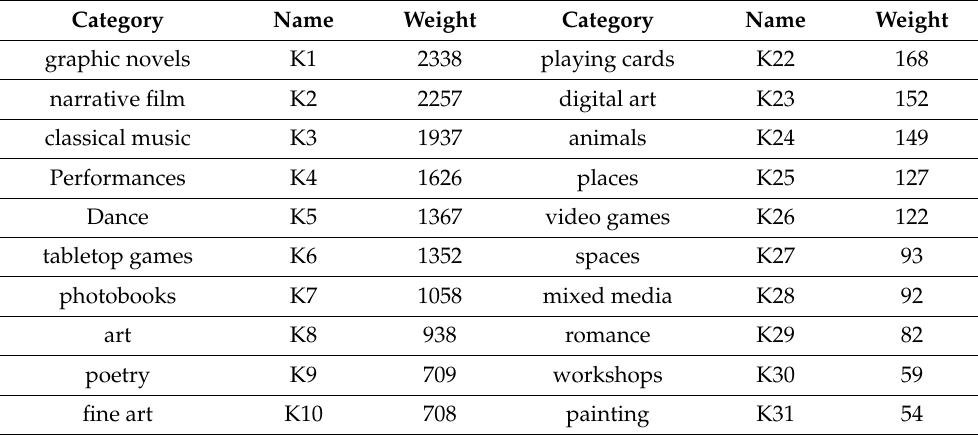
Table 4. List of categories and their